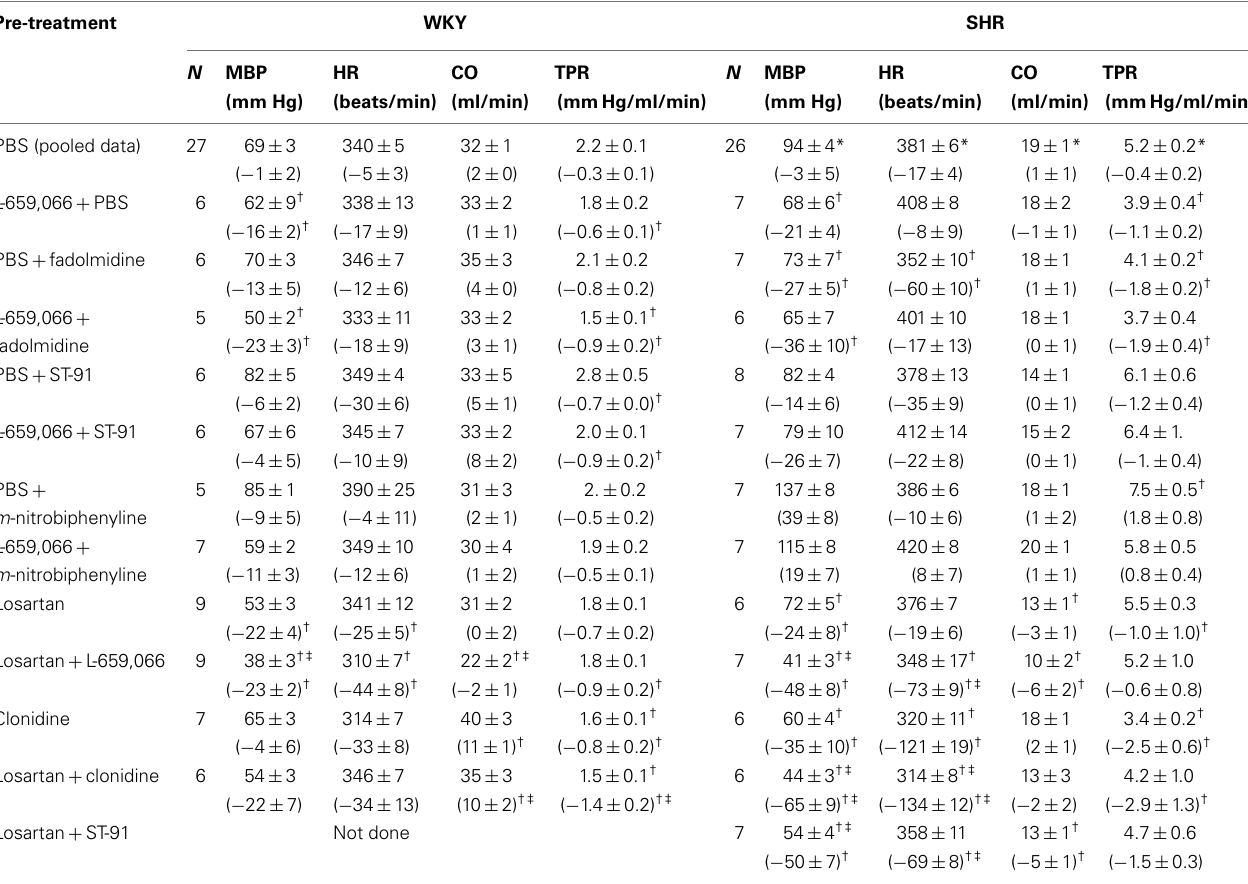
Table 3 | Cardiovascular baselines prior to tyramine and, in parenthesis, the response to pre-treatment.